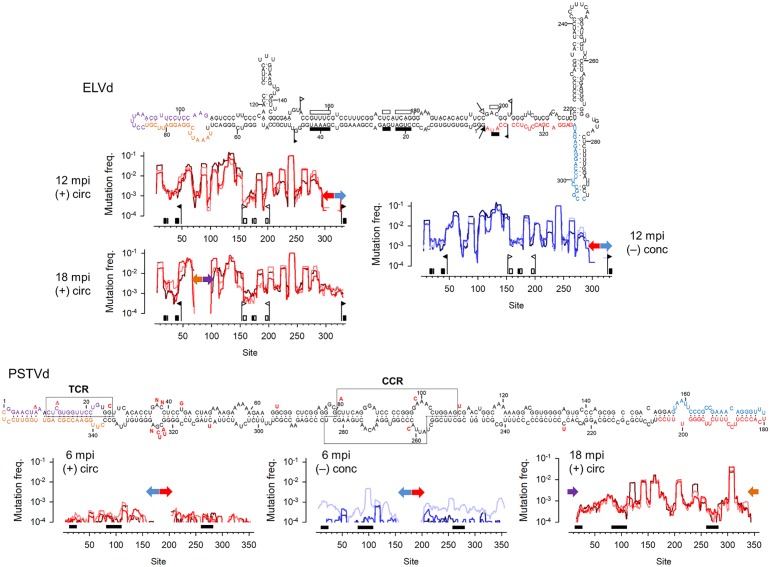
Genetic diversity of ELVd and PSTVd in eggplant as determined by DS.The viroid circular (+) strand sequences are depicted. Primers used for RT-PCR from samples taken at 6/12 mpi (run 1) are indicated with red and blue font in the sequences and those used for RT-PCR from samples taken at 18 mpi (run 2) are shown in orange and purple (see S1 Table for details). The skyline plots show mutation frequencies (total mutations/total reads per site) averaged over a 10-nucleotide sliding window to smooth the plot. Thick colored arrows in these graphs indicate the positions encompassed by RT-PCR primers, with the same color code as for the sequences. Red plots correspond to circular (+) strands and blue plots to (–) oligomers. Light, bright, and dark color correspond to plants 1, 2, and 3, respectively. In the ELVd sequence and skyline plots, key elements of the (+) hammerhead ribozyme are shown in black and those of the (–) hammerhead ribozyme in white. Flags indicate the regions encompassed by the hammerhead ribozymes of each polarity, arrows indicate self-cleavage sites in the sequences, and conserved motifs are indicated with boxes. By convention, ELVd sites are numbered starting from the (+) strand self-cleavage site. In the PSTVd sequence, the central conserved region (CCR) and terminal conserved region (TCR) are boxed and also indicated by black bars in the skyline plots. Red bases shown next to the PSTVd sequence indicate mutations previously shown to have lethal effects (see text for references). By convention, PSTVd sites are numbered starting from the left terminal loop. A site-by-site list of all mutations is available in S1 Dataset (6/12 mpi) and S2 Dataset (18 mpi).